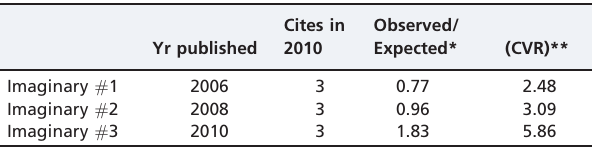
Table 4 - The use of CONTINUOUSLY VARIABLE RATING: an imaginary example.